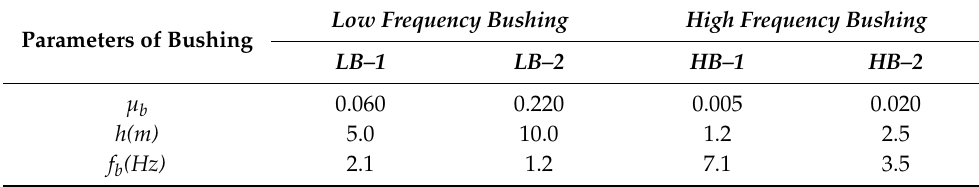
Table 1. Parameters of bushings.